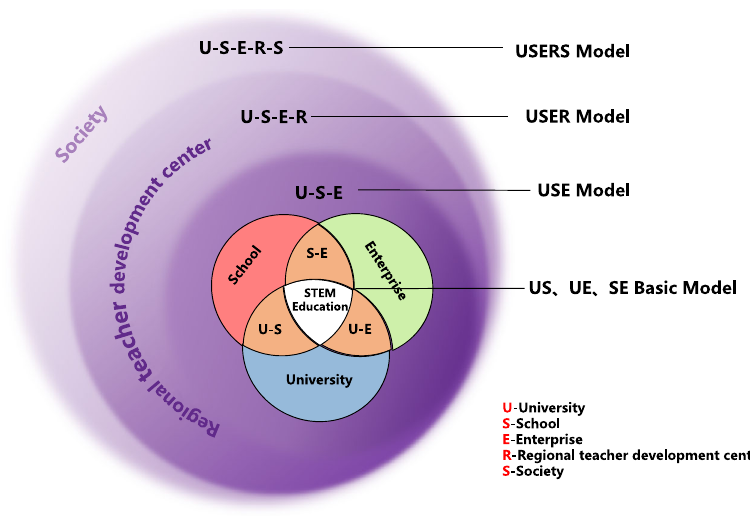
Fig. 3 The USERS framework for collaborative STEM education development. Starting from the Clastotype including US, UE, and SE, the USERS framework ultimately points to a relatively complete collaborative ecology for STEM-related education. In this way, all parties support and in fl uence each other, make up for de fi ciencies, and drive STEM-related education forward in a dynamic and balanced